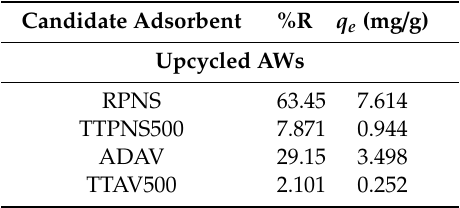
Table 2. An assessment of the performance of the four adsorbents obtained by upcycling of the AWs in terms of %R and q e . The experimental conditions are pH = 7.00 ± 0.20, initial drug concentration [SARA] = 40 ppm, adsorbent dose (AD) = 50 mg / 15 mL, and contact time (CT) = 30 min. The obtained values of %R and q e shown were determined utilizing Equations (1) and